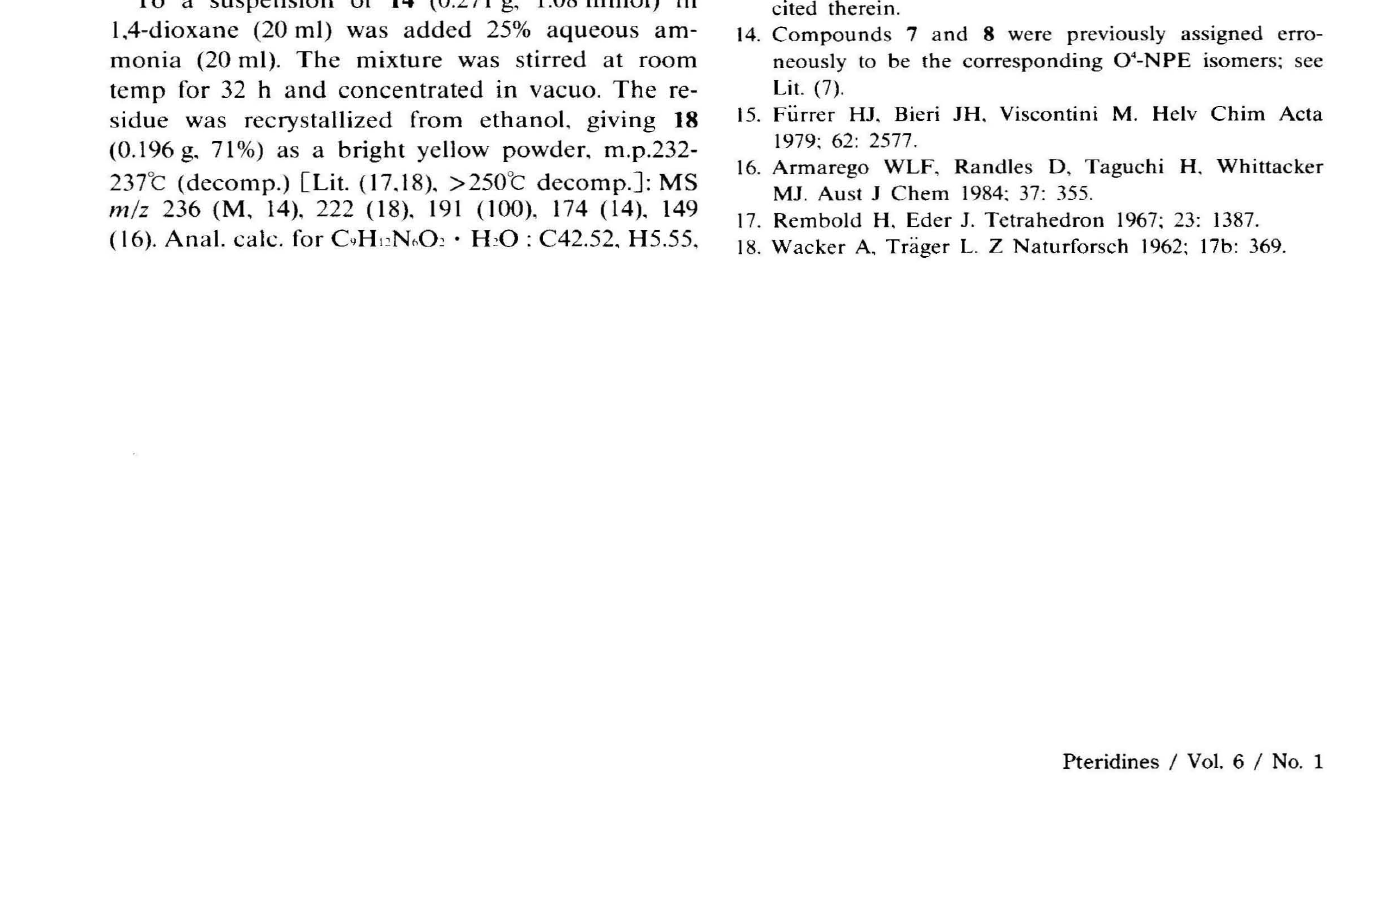
residue was crystallized from MeOH-chloroform-ether, giving 17 (44 mg, 70%) as a pale yellow powder, m .p. 17S-176SC : Rr 0.40 (A). Anal calc. for CIlH'HNhO,: CSO.97, HS.92, N27.43; found: C50.85, H6.04,